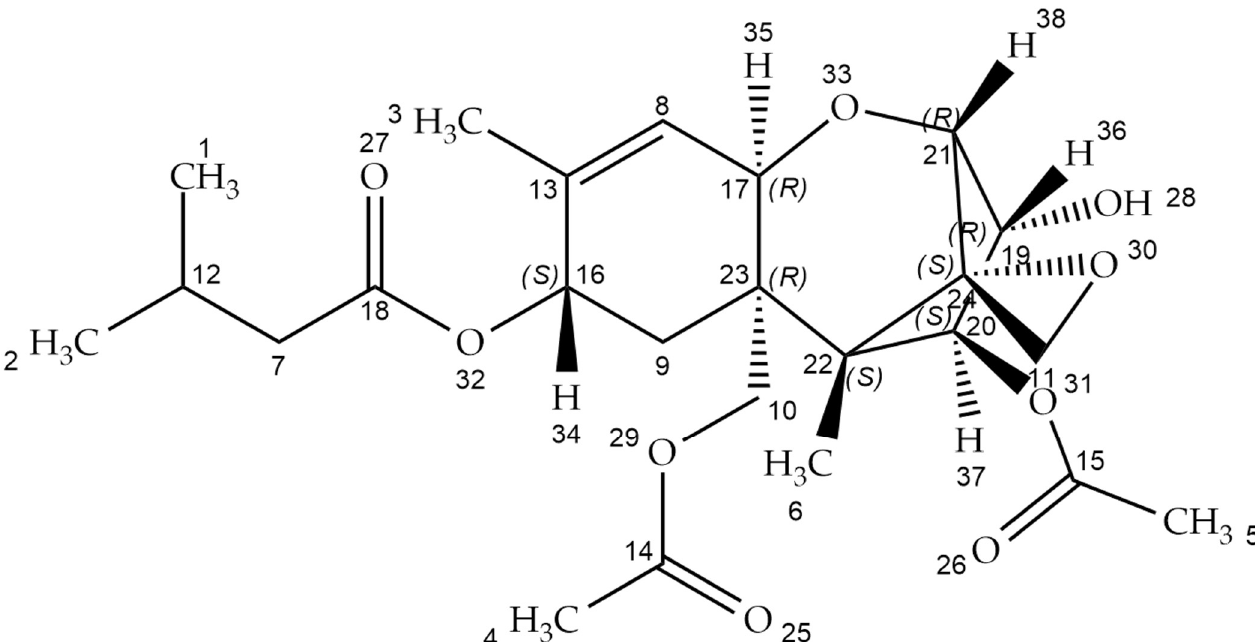
Figure 1. T-2 toxin chemical structure (structure generated from InChI code. Available online: https://pubchem.ncbi.nlm.nih.gov/ (accessed on 21 April 2022)).